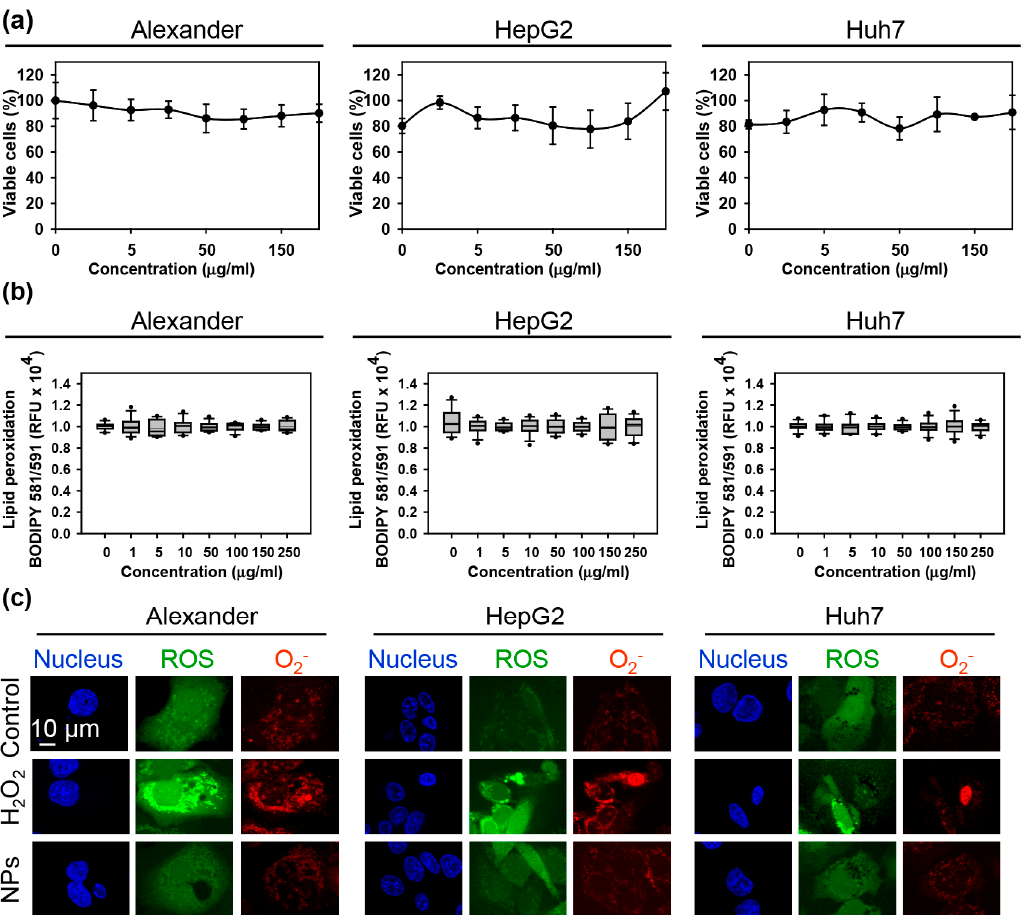
Figure 1. Assessment of the nanoparticle uptake and biocompatibility in three distinct hepatic cell lines. ( a ) Cytotoxicity of nanoparticles in three distinct cell lines: Alexander, HepG2, Huh7. Cytotoxicity was assessed using alamarBlue assay. Data are expressed as means ± SEM ( n = 4). ( b ) Detection of lipid peroxidation using BODIPY ™ 581 / 591 C11 lipid peroxidation sensor (ThermoFisher Scientific). Data are expressed as means ± SEM ( n = 3). ( c ) NP treatment did not induce intracellular ROS / Superoxide (O 2 − ) production and di ff erent subcellular accumulation. Cells were treated for 24 h with nanoparticles 50 µ g Fe mL − 1 . NP-treated cells were stained with ROS / Superoxide Detection Assay Kit and imaged by confocal microscopy. Representative images out of three independent experiments are shown. Positive control 1 mM H 2 O 2 for 30 min was used.